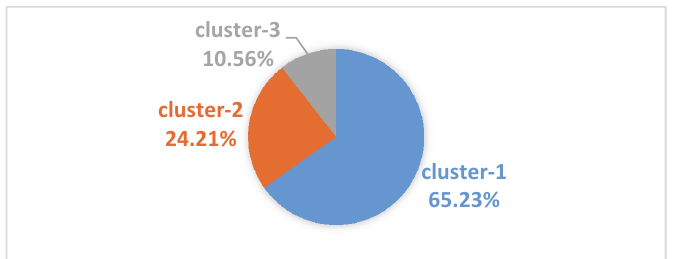
Fig. 4. Percentage of customer loyalty